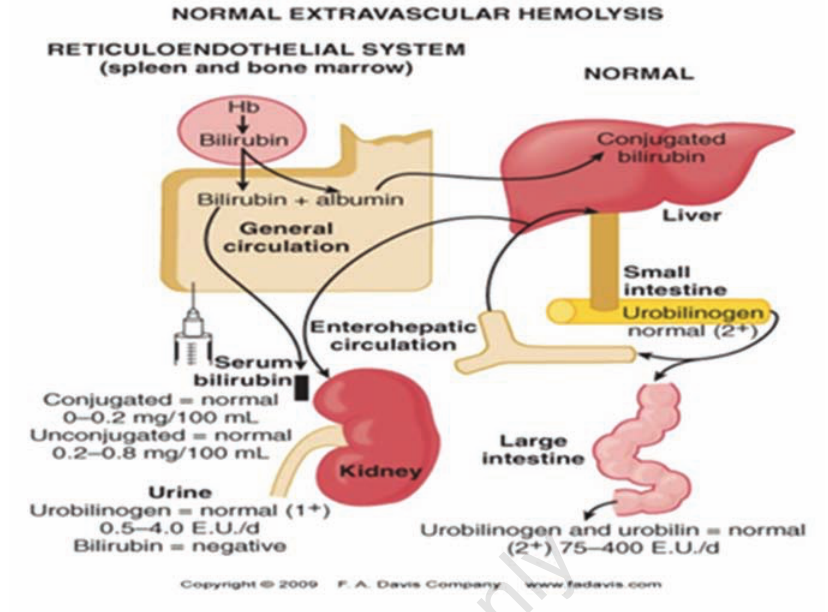
Figure 9. Extravascular destruction of RBCs. 73 Legend: Extravascular hemolysis occurs when damaged or abnormal RBCs are cleared from the circulation by cells of the spleen, liver, and bone marrow similar to the process by which senescent RBCs are removed. The spleen usually contributes to hemolysis by destroying mildly abnormal RBCs or cells coat- ed with warm antibodies. An enlarged spleen may sequester even normal RBCs. Severely abnormal RBCs or RBCs coated with cold antibodies or complement (C3) are destroyed within the circulation and in the liver, which (because of its large blood flow) can remove damaged cells